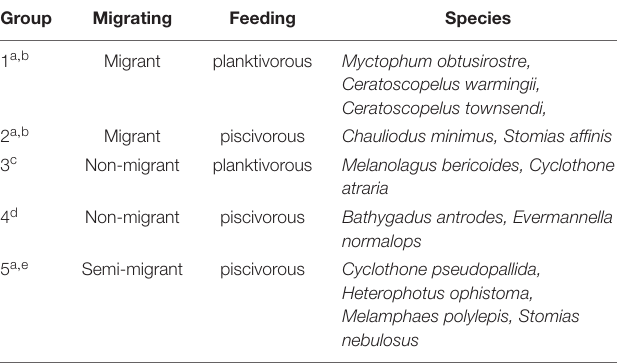
TABLE 2 | Fish groups based on migrating and feeding